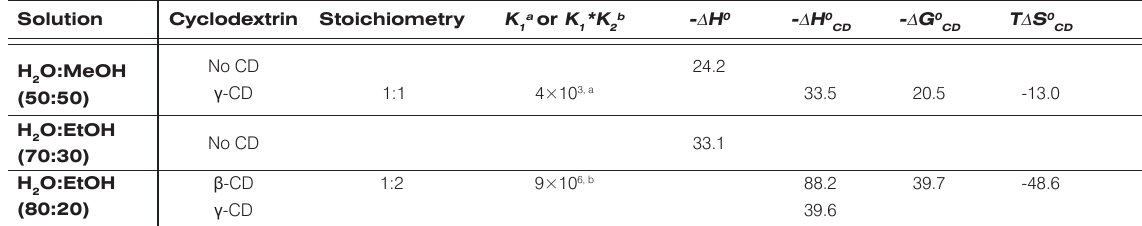
Table 2. Stoichiometry, stability constants (M -1 ) and thermodynamic parameters (kJ mol -1 ) for the complexes of 1 with 2 and 3 . Solution Cyclodextrin